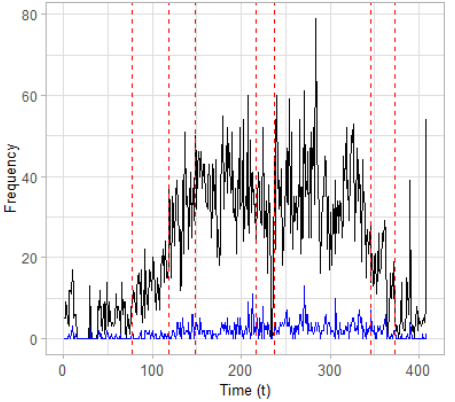
Figure 7. Application of CPD on the two-dimensional time